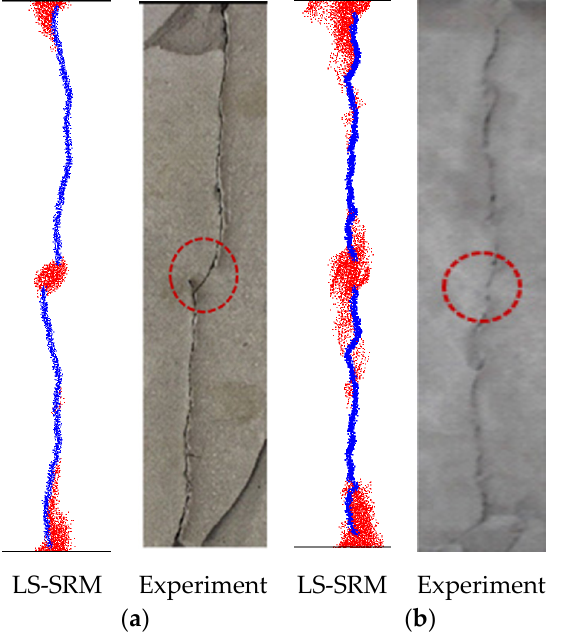
Figure 11. The failure mechanism of LS-SRM and experimental of ( a ) noncoplanar rock bridge specimens and ( b ) coplanar rock bridge specimens. Table 4. Experimental and numerical results on specimens of the noncoplanar and coplanar rock bridge.